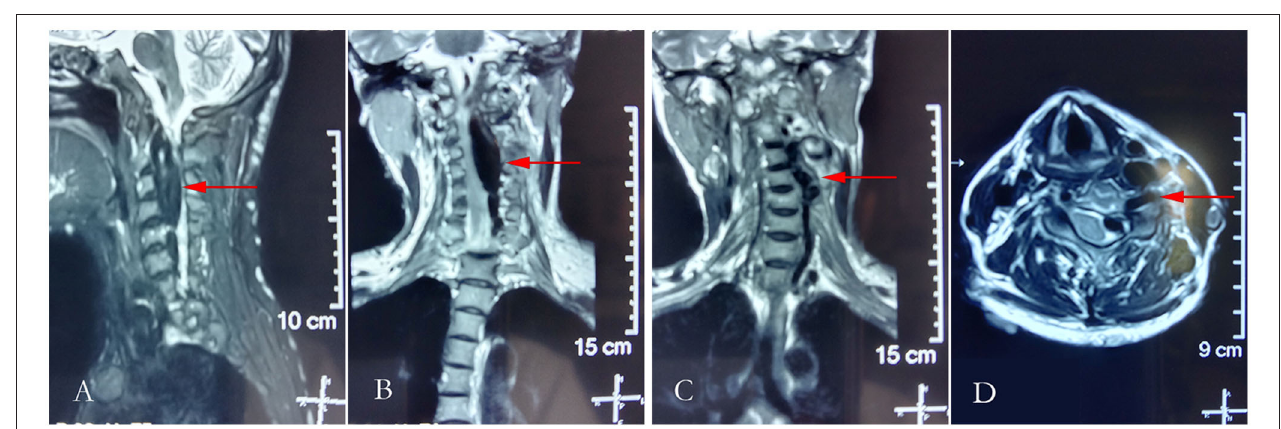
FIGURE 2 | Cranial T2-weighted magnetic resonance imaging. (A) Sagittal plane of the neck; (B,C) the coronal plane of the neck; and (D) horizontal plane of the